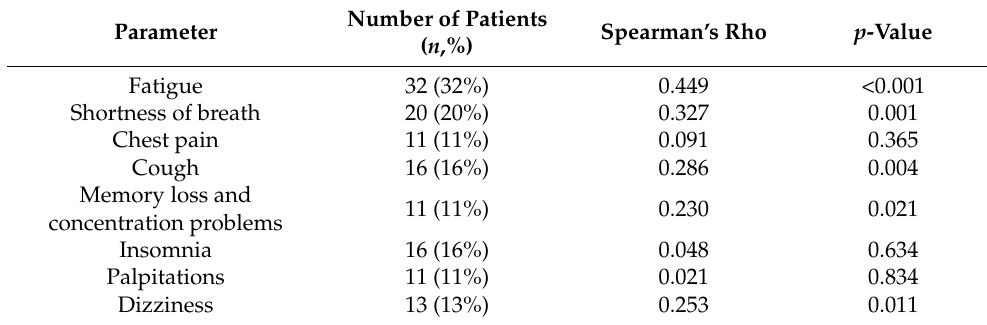
Table 6. Symptoms for patients at 3 months and correlations with pulmonary